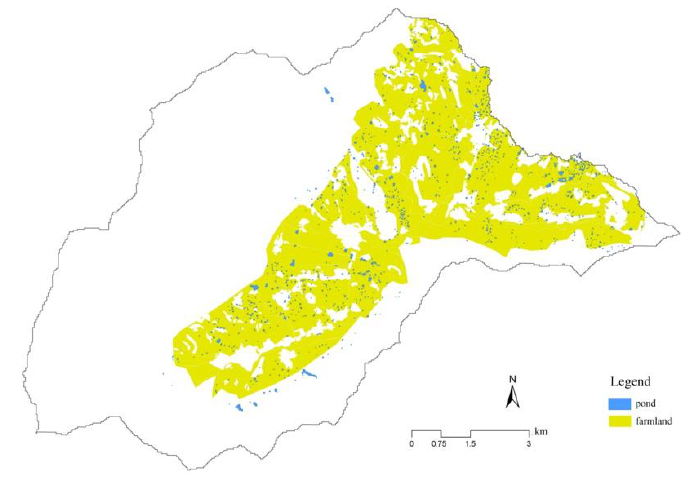
Figure 16. The farmland dataset.